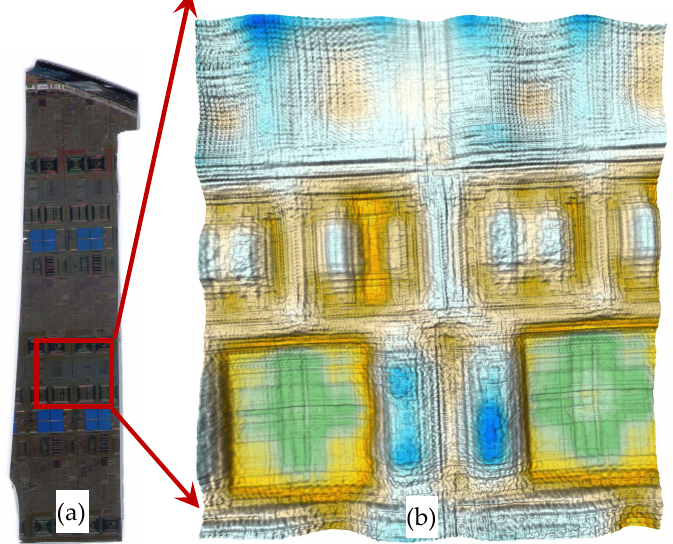
Figure 3. ( a ) Chip side of the wafer fragment’s optical image. ( b ) T-ray image (10 mm × 11 mm) corresponding to the rectangle shown in ( a ).